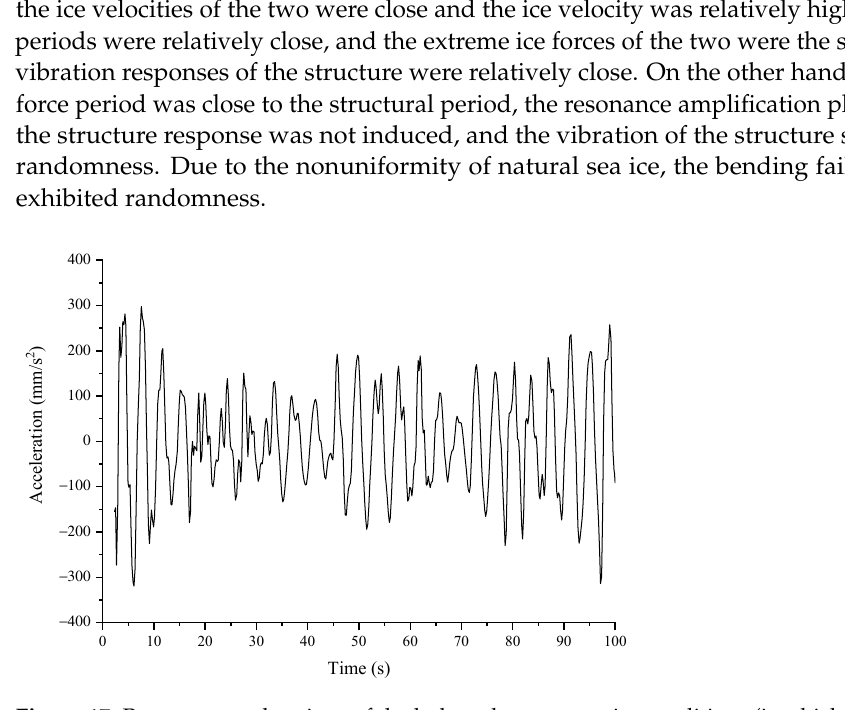
Table 6. The design ice load for the simulation.